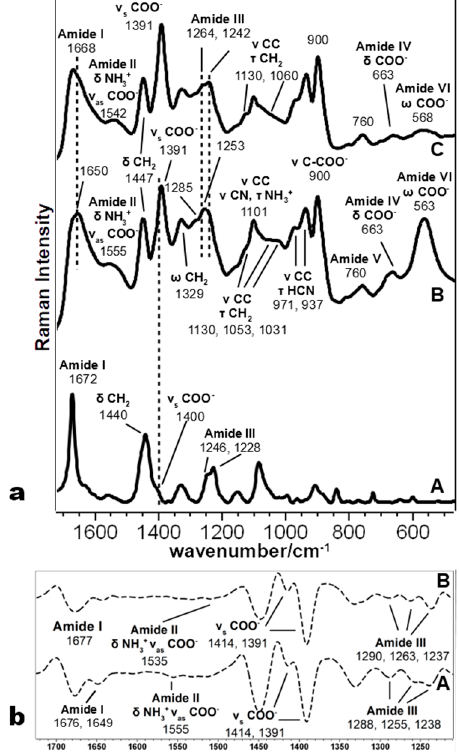
Figure 2. ( a ) Comparison of the Raman spectrum (A) and SERS spectra of Pept2 as-synthesized (B) and after irradiation (C); ( b ) second derivative SERS spectra of Pept2 before (A) and after (B) irradiation.